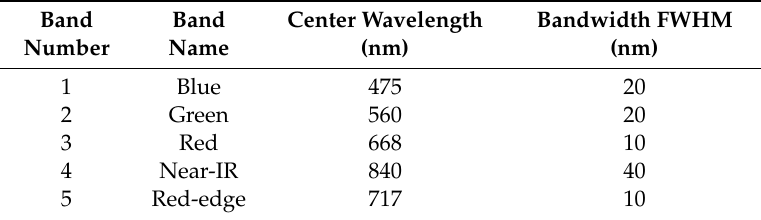
Table 2. Spectral bands with center wavelength and bandwidth of the MicaSense RedEdge-M multispectral camera.